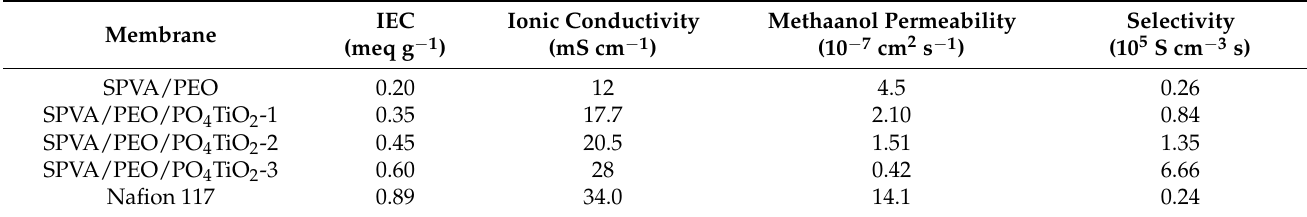
Table 2. Ionic conductivity, methanol permeability, IEC and selectivity of the fabricated membranes and Nafion 117 [1].